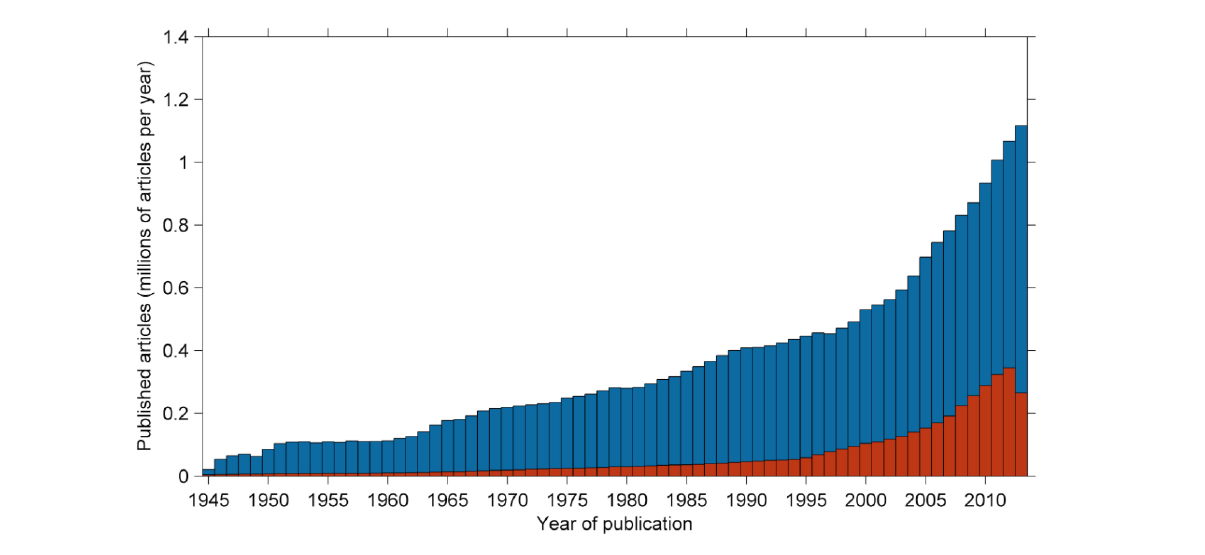
Figure 1. Volumes of articles currently indexed by PubMed (blue) and volumes freely available via PubMed Central (orange), arranged by year of publication, for articles published between 1945 and 2013 (data accessed 17 March